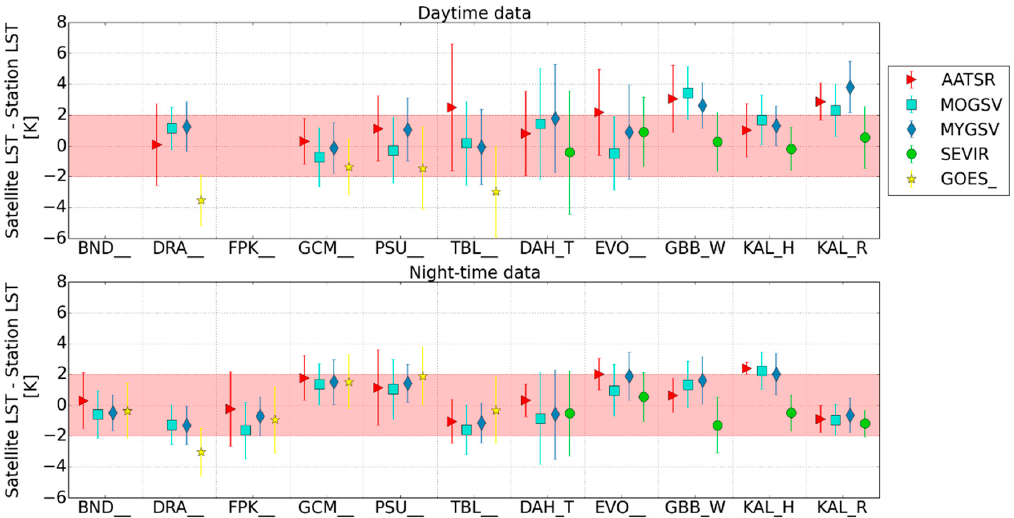
Figure 8. Validation results for the years 2010–2012. The upper plot shows the daytime accuracies, the lower one the night-time accuracies. The ranges shaded in red indicate the accuracy range of ±2.0 K and the error bars are the robust STDs. Bondville (BND) and Fort Peck (FPK) daytime data were excluded from the validation due to very strong seasonal cycles.